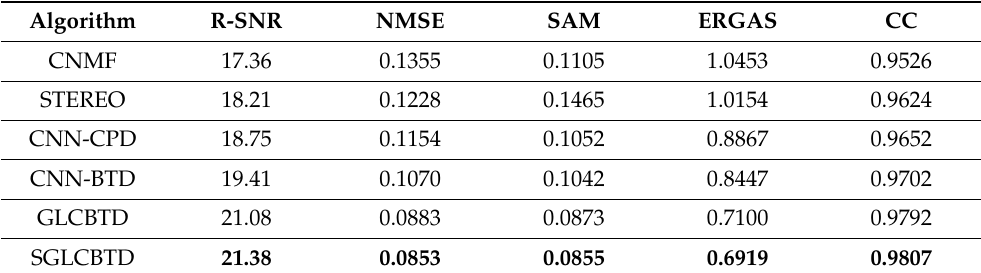
Table 2. Quantitative indices comparison on the Pavia University dataset.